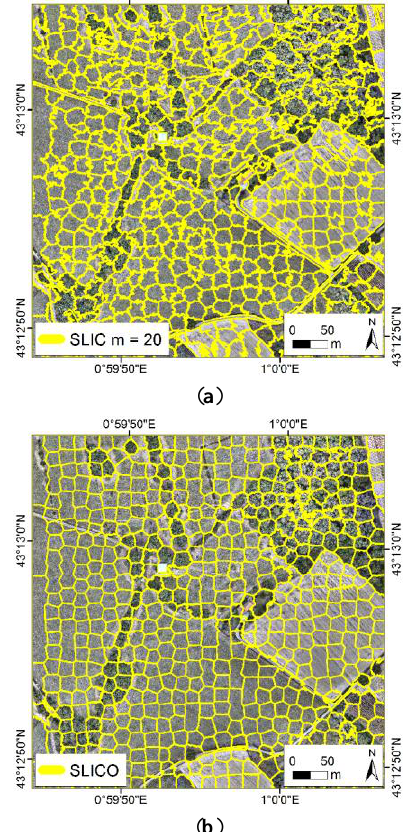
Figure 1. ( a ) SLIC ( m = 20) and ( b ) SLICO applied to an UAV orthoimage of Toulouse with 0.05 m ground sample distance (GSD) and k = 625. SLIC generates regular-shaped superpixels in untextured regions and highly irregular superpixels in textured regions. SLICO generates regular-shaped superpixels across the scene, regardless of texture. SLICO superpixels are spatially more compact, but spectrally more